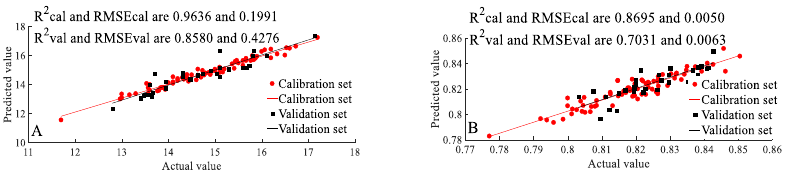
Figure 7. TSSC and water content detection based on deep learning. ( A ) TSSC detection; ( B ) water content detection.